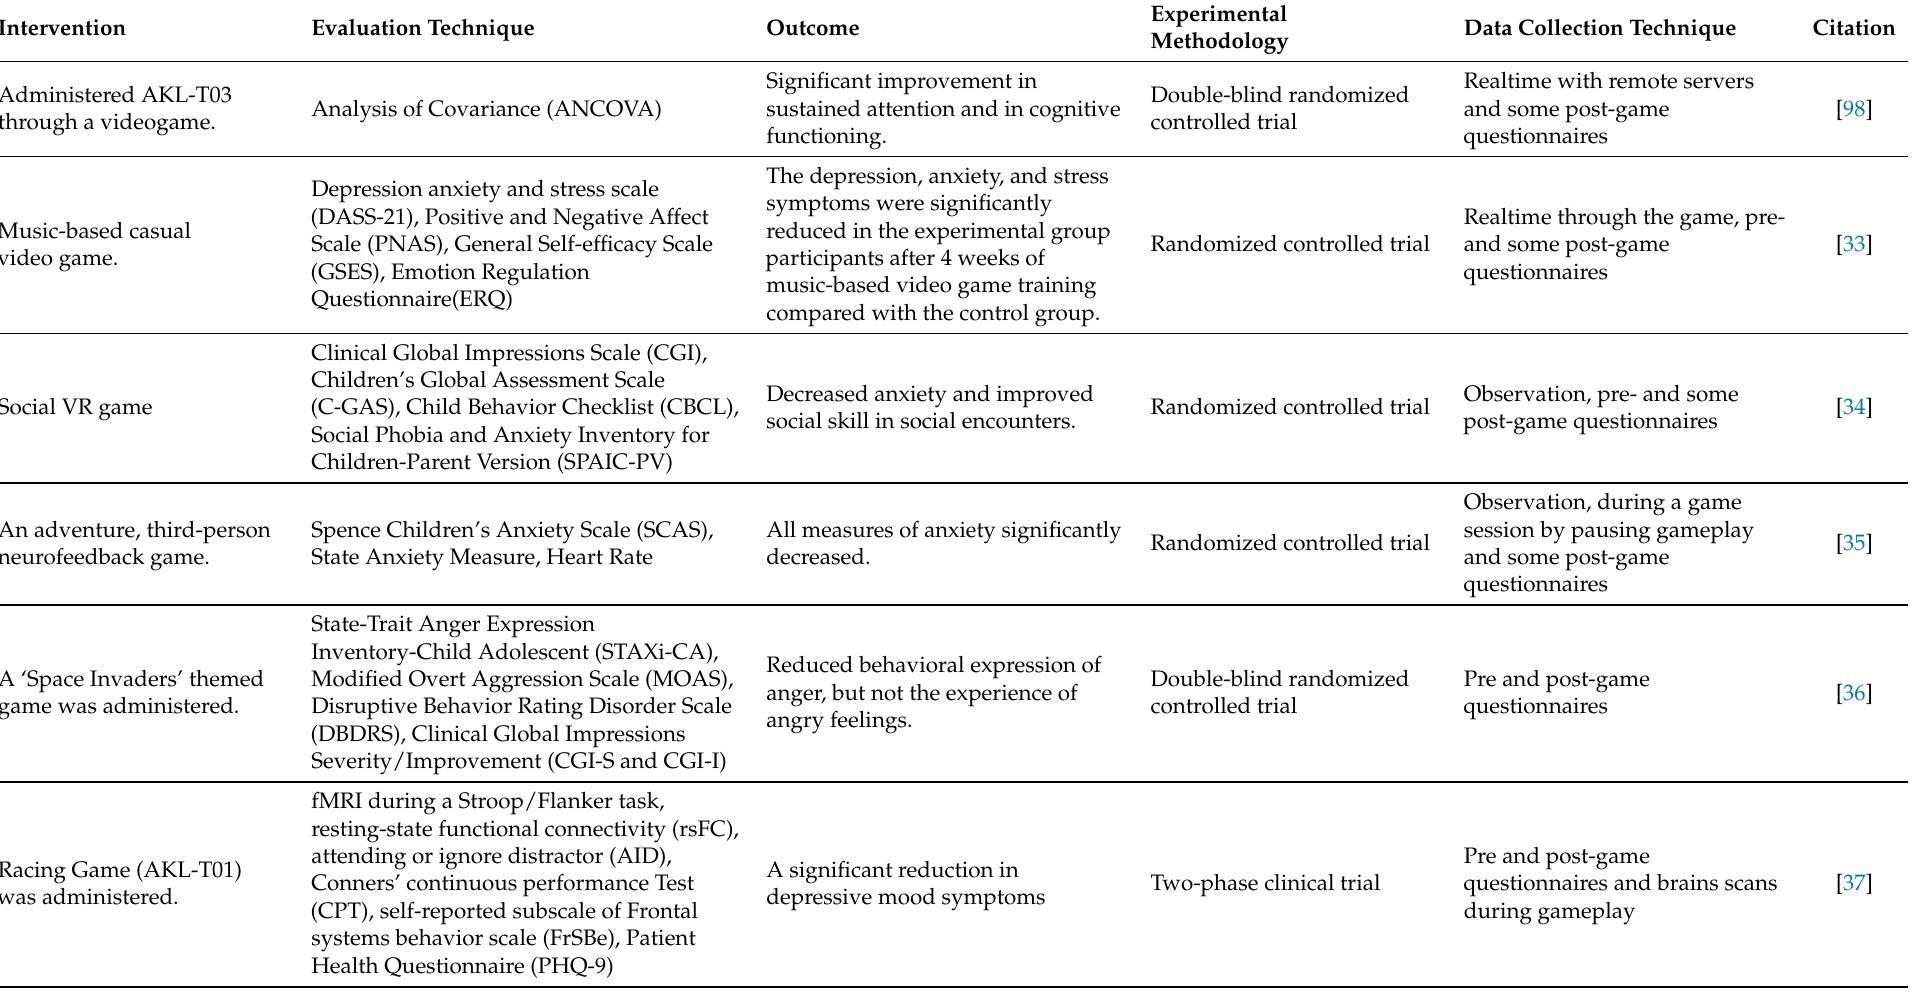
Table 4. Serious game intervention methodologies and